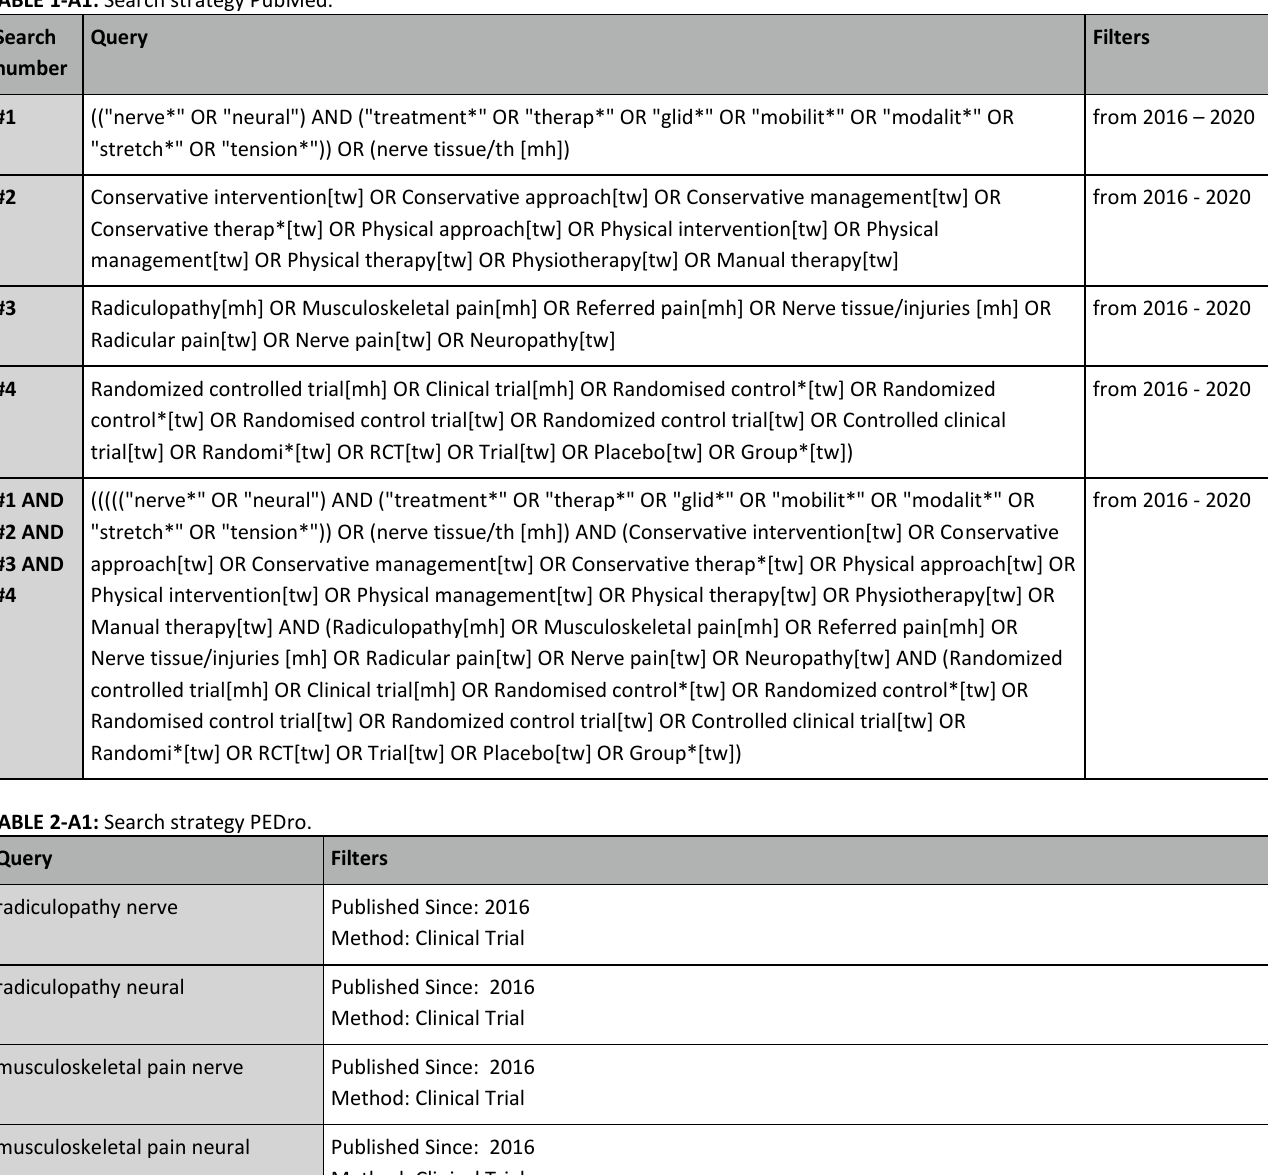
TABLE 1-A1: Search strategy PubMed.